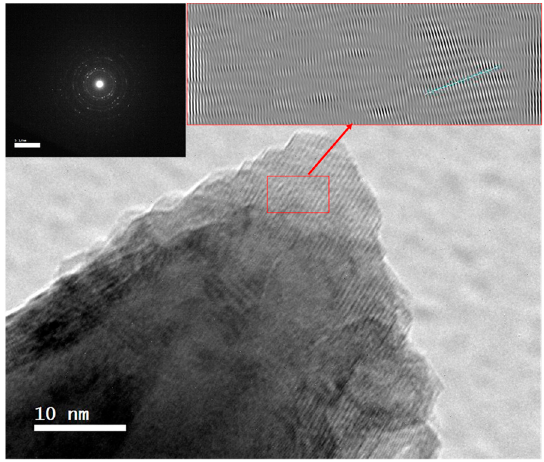
Figure 4. The high resolution TEM images of Fe 10 Ni 90 molar ratio synthesized using 0.1 M metal concentration and 80 mL reaction volume carried out for 15 min at 1400 rpm and 95–98 °C.